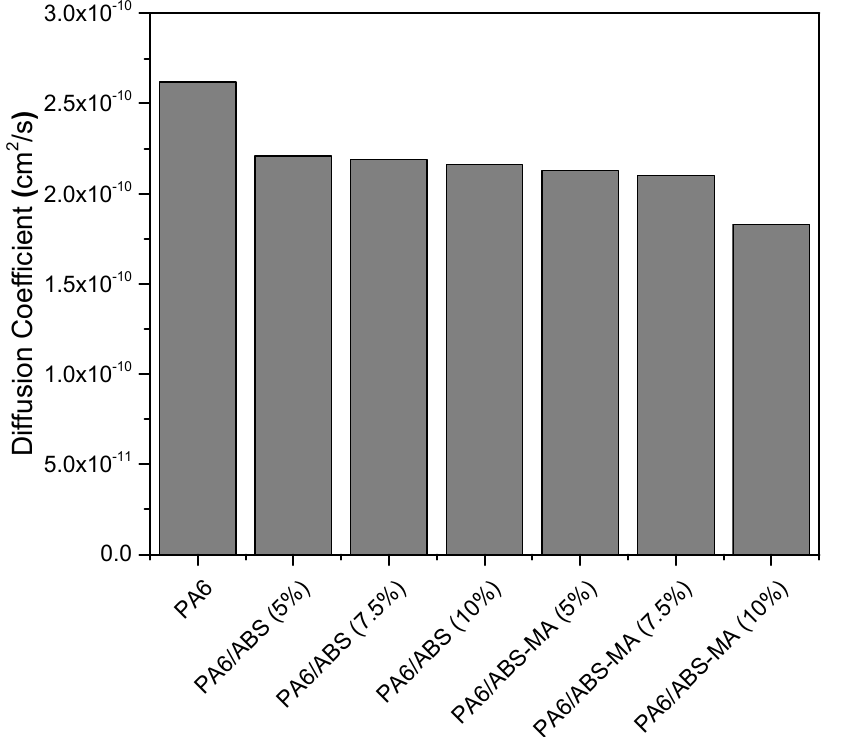
Figure 20. Diffusion coefficients of PA6 and its blends.